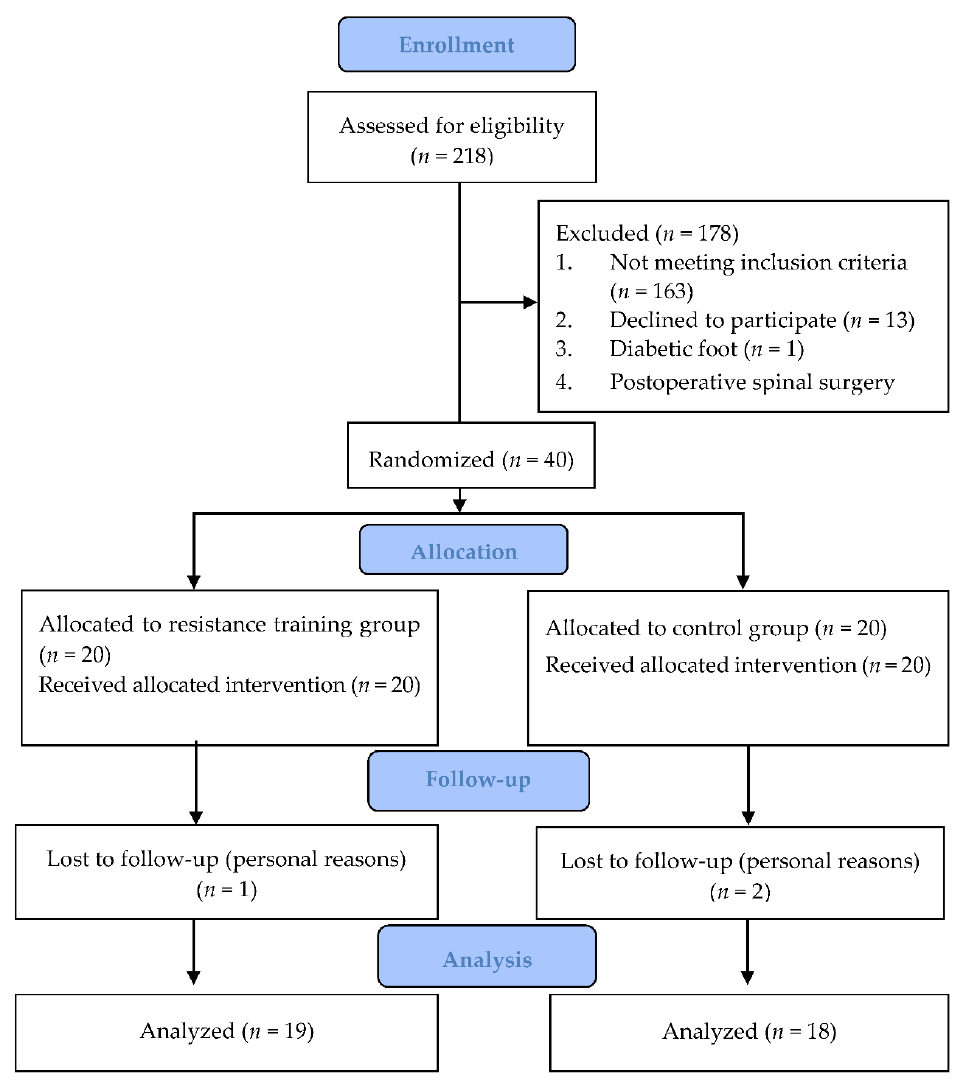
Figure 2. CONSORT flow diagram. Table 1. Baseline characteristics of patients.